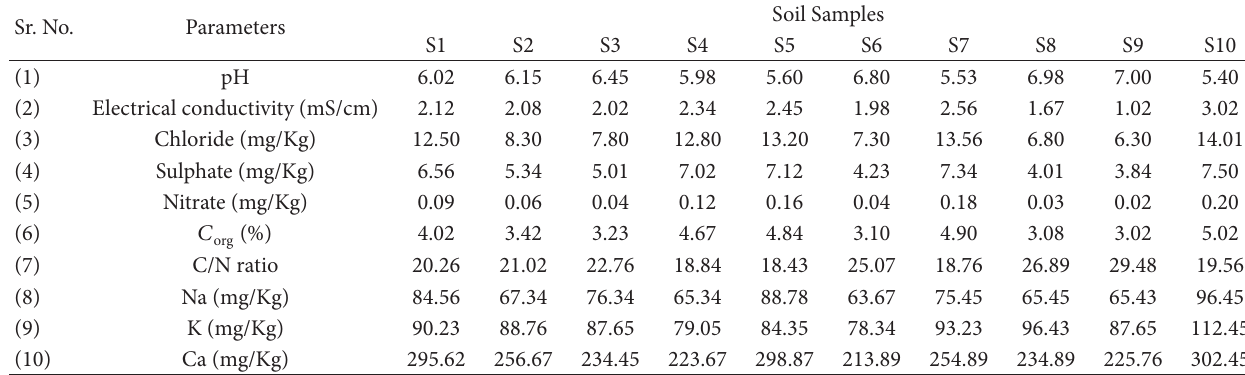
T 1: Physico-chemical parameters of the soil samples.